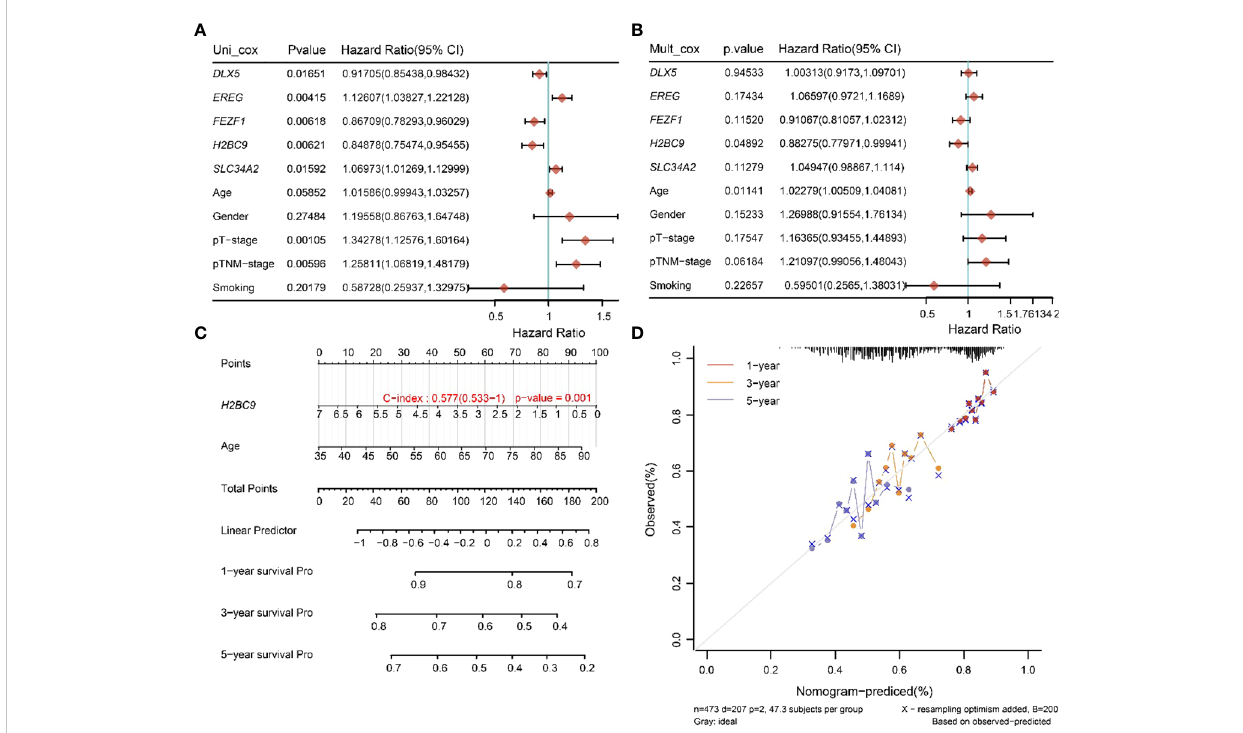
FIGURE 7 Univariate and multivariate Cox screening prognostic factors. (A, B) Analysis of clinical factors and risk scores using univariate Cox analysis, and multivariate Cox analysis was used to analyze signi fi cant factors. (C) Construction of clinical diagnosis column line graphs based on clinical characteristics and risk scores. (D) Calibration plots for predicting recurrence at 1, 3, and 5 years. The x-axis indicates the recurrence probability predicted from the column line graphs, and the y-axis indicates the actual recurrence